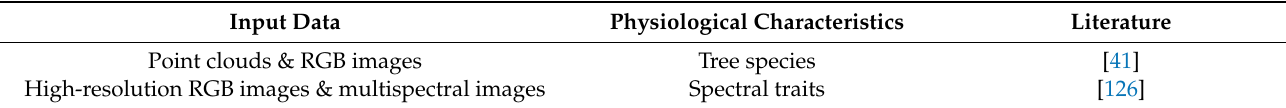
Table 9. Input data used in the studies considering tree species and spectral traits.